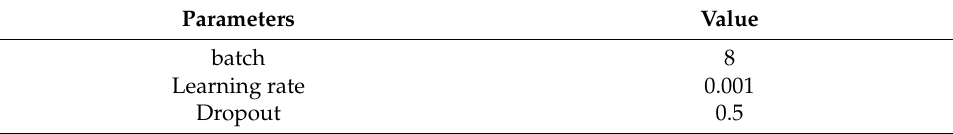
Table 4. ResNet-50 hyperparameter